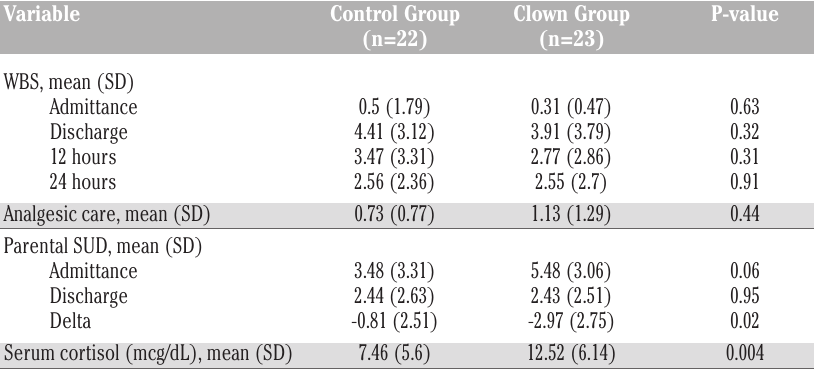
Table 2. Clinical